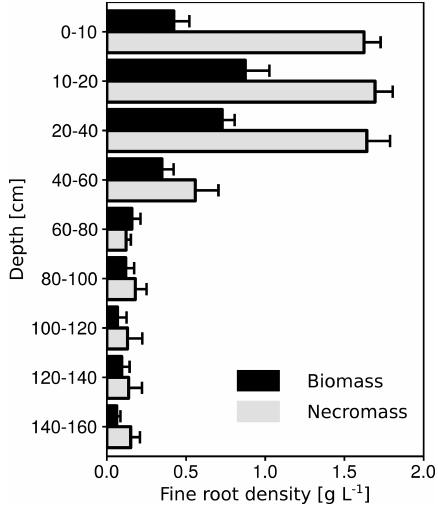
Figure 12. Mean fine root density for biomass and necromass of the subsoil observatories. Error bars represent the standard